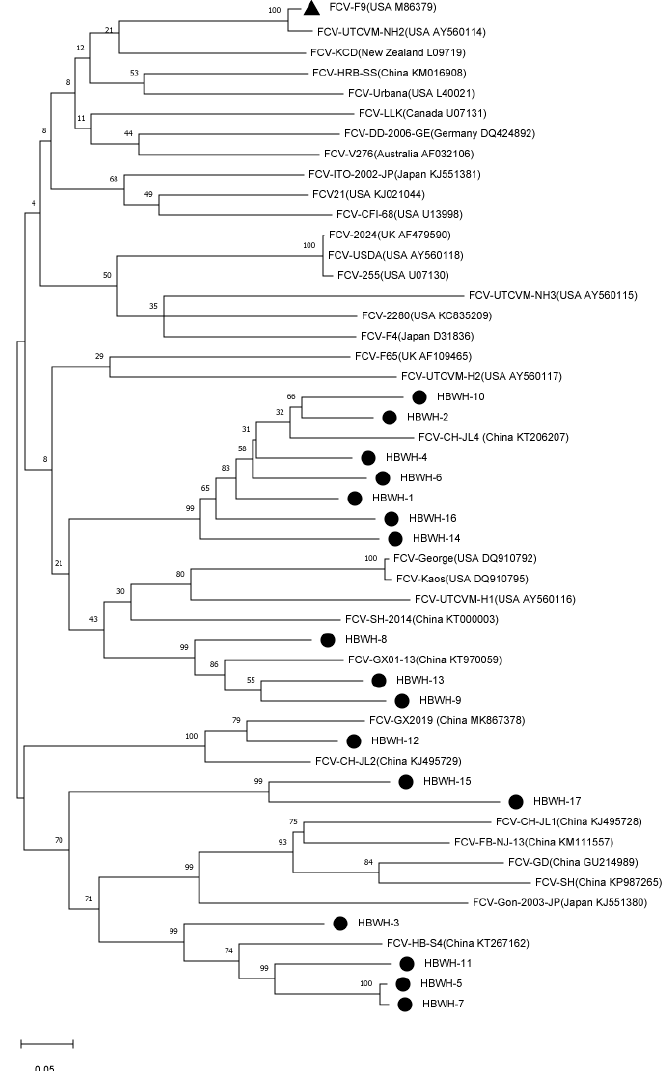
Figure 5. Nucleotide evolutionary tree established by 17 feline calicivirus (FCV) and 34 reference strains. A maximum likelihood (ML) phylogenetic tree was established using the Jones–Taylor–Thornton (JTT) model nucleotide substitution model, 1000 bootstrap replications. Black triangles identify F9-vaccine-associated strains (GenBank No. M86379), and black circles identify 17 isolates in this study.